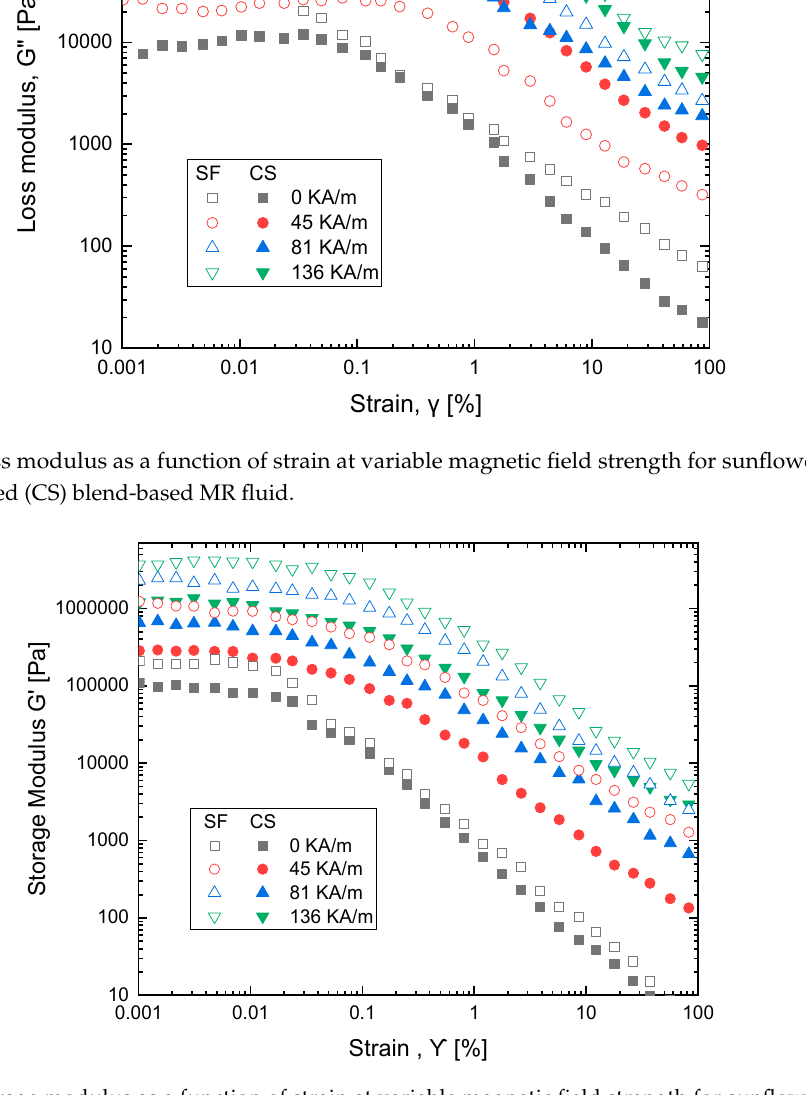
Figure 8. Storage modulus as a function of strain at variable magnetic field strength for sunflower (SF) and cottonseed (CS) blend-based MR fluid.